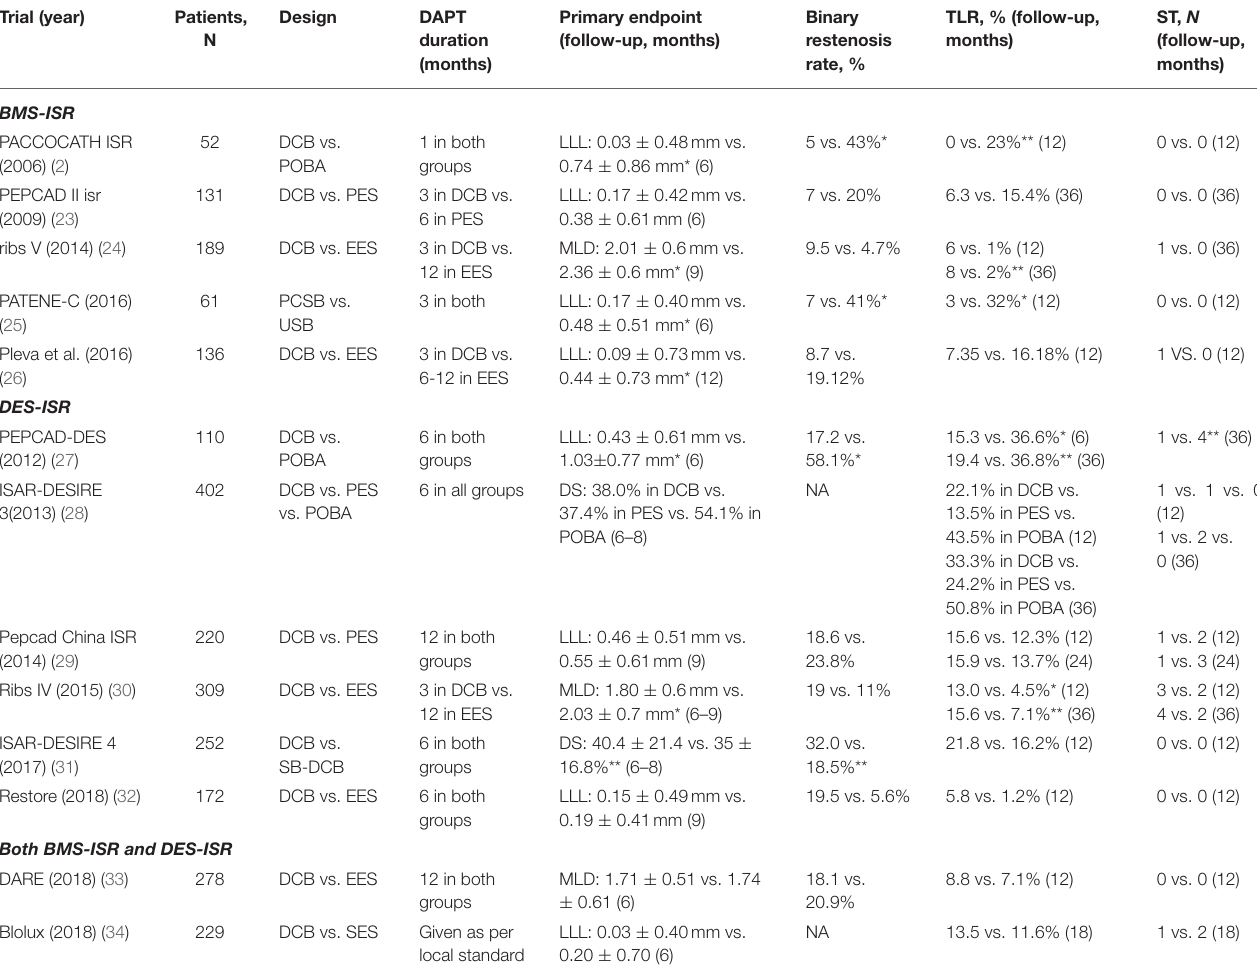
DAPT,dualanti-platelettherapy;TLR,targetlesionrevascularization;ST,stentthrombosisincludingdefiniteandpossible;DCB,drug-coatedballoon;POBA,plainoldballoonangioplasty; LLL,latelumenloss;PES,paclitaxel-elutingstent;EES,everolimus-elutingstent;MLD,minimallumendiameter;PCSB,paclitaxel-coatedscoringballoon;USB,uncoatedscoringballoon; DS, diameter restenosis; SB-DCB, scoring balloon before drug-coated balloon; SES, sirolimus-eluting stent. * P < 0.01 vs. non-DCB group. ** P < 0.05 vs. non-DCB